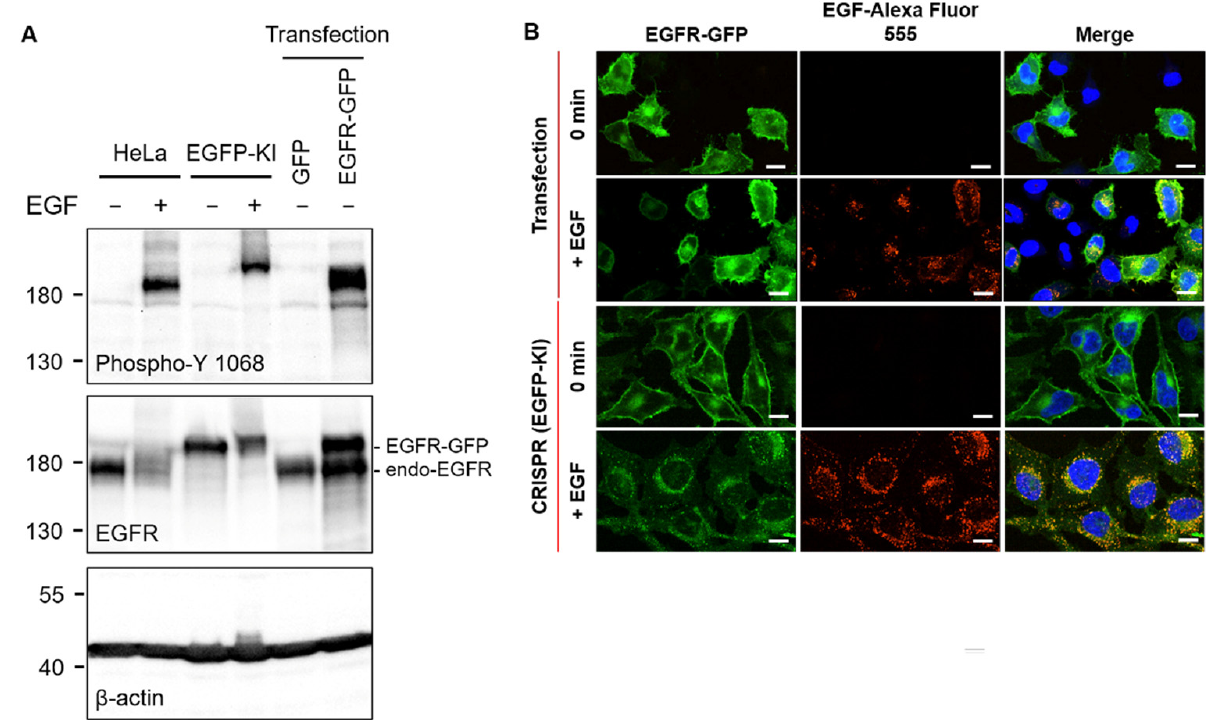
Figure 1. Comparison of EGFR-GFP in transfected (overexpression) and CRISPR/Cas9-mediated EGFP-KI HeLa cells. ( A ) Autophosphorylation levels at Tyr1068 of EGFR-GFP in transfected and EGFP-KI cells. Wild-type HeLa cells were used as a negative control; ( B ) Confocal fluorescence microscopy assessment of EGFR-GFP distribution and co-localization with EGF in live cells treated with EGF-Alexa Fluor 555 (15 min, 37 °C). Scale bar, 20 µm.